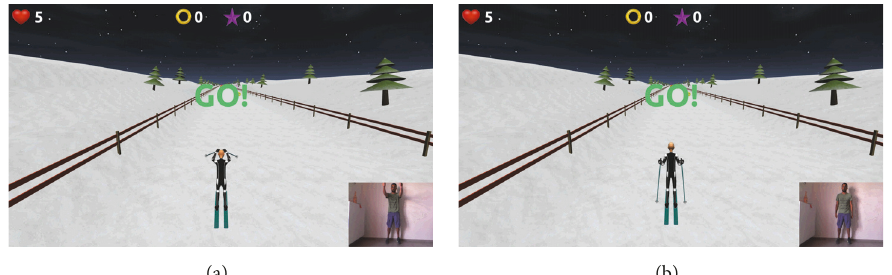
Figure 11: Screen snapshots displaying the “Push Both Ski Poles” gesture in action; a shows the player having stretched both arms to a frontal extension, followed by b lowering them to the initial relaxed position.